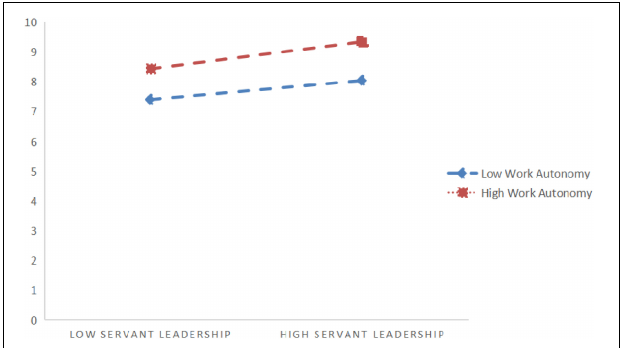
FIGURE 3 | Figure of regulating